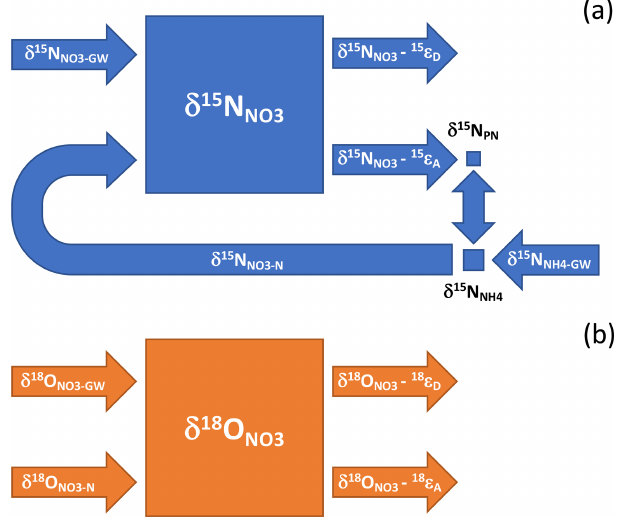
Figure 9. Conceptual illustration of the influence of nutrient spi- raling on the N and O isotope ratios of riverine NO − . Nutrient 3 spiraling describes the cycling of nutrients as they are assimilated from the water column into biomass that is temporarily retained on the benthos and then mineralized and released back into the water column or denitrified. (a) The δ 15 N of the riverine NO − reservoir 3 integrates the NO − and NH + delivered continually from ground- 3 4 water ( δ 15 N NO and δ 15 N NH ), minus the NO − removed 3 3 -GW 4 -GW concurrently by sedimentary denitrification – the δ 15 N of which depends on the sedimentary isotope fractionation communicated to the water column reservoir, 15 ε D . Given the small size of the respective PN and NH + pools relative to NO − , ammonification 4 3 and subsequent nitrification produce NO − with a δ 15 N NO value 3 3 -N approximating that lost concurrently to assimilation ( δ 15 N NO – 15 3 ε A ), notwithstanding the NH + input from groundwater. The in- 4 put of groundwater NH + ( δ 15 N NH ) implicitly subsumes the 4 4 -GW input of reactive allochthonous PN and DON. (b) The riverine δ 18 O NO integrates the NO − input from groundwater and precip- 3 3 itation ( δ 18 O NO ) and from in-river nitrification ( δ 18 O NO ), 3 -GW 3 -N minus NO − lost to algal assimilation and sedimentary denitrifica- 3 tion – whose respective values depend on the net isotope effects associated with assimilation and denitrification, 18 ε A and 18 ε D